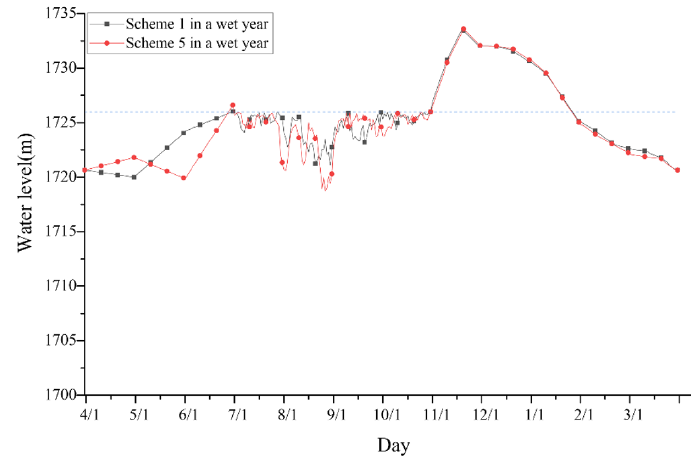
Figure 8. Water level process lines in a wet year.